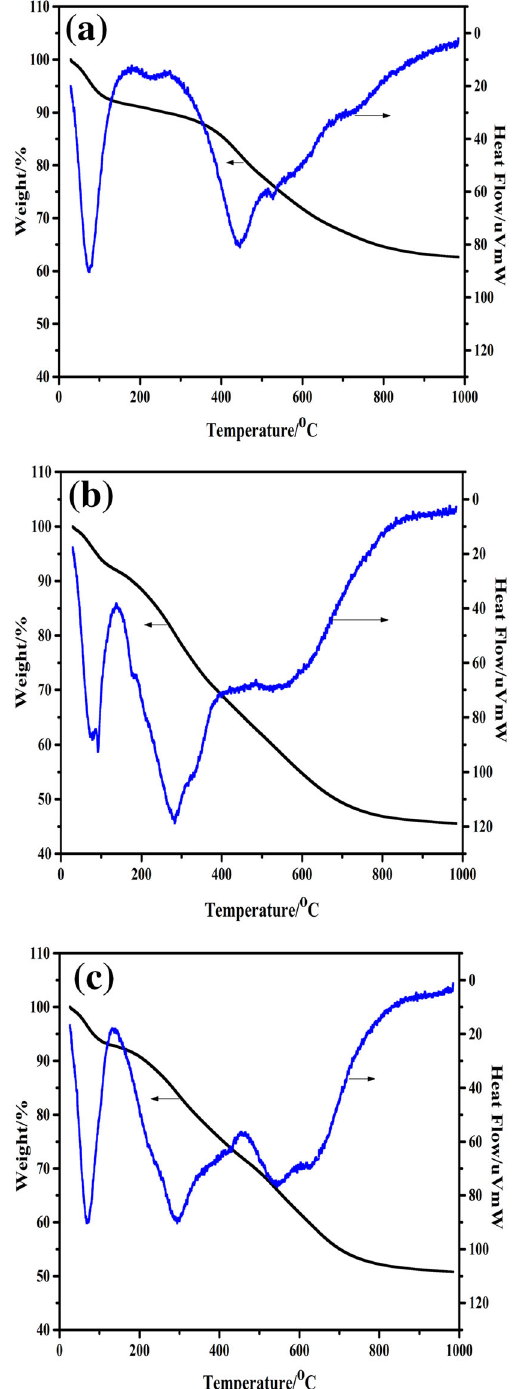
Fig. 2 The TG and DTG curves of coal and its pretreatment a coal, b Coal mild stirring in HNO 3 at room temperature for 24 h, c Coal stirring for 24 h of reflux after mild stirring in HNO 3 at room temperature for 24